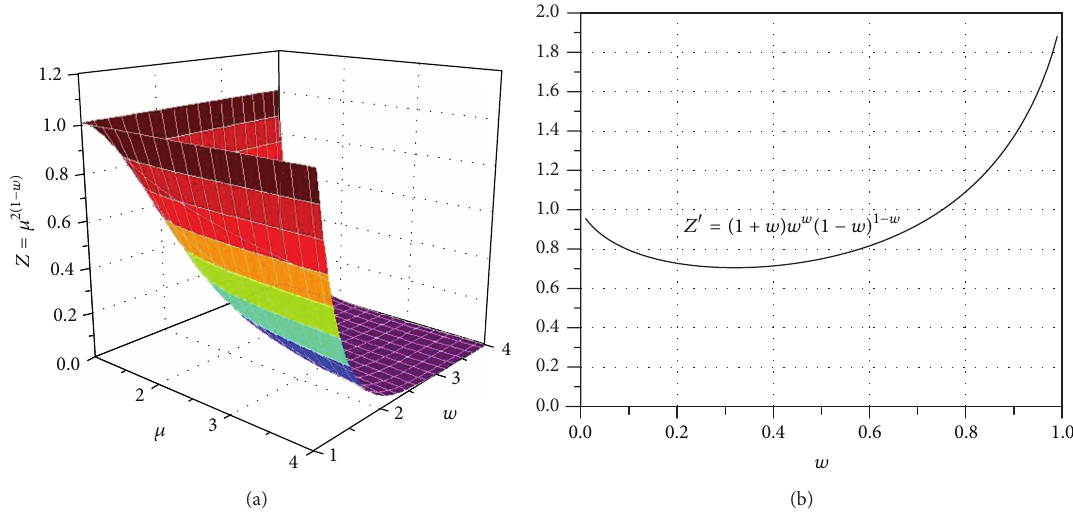
Figure 2: Function chart for 𝑍 and 𝑍 󸀠 in special interval.